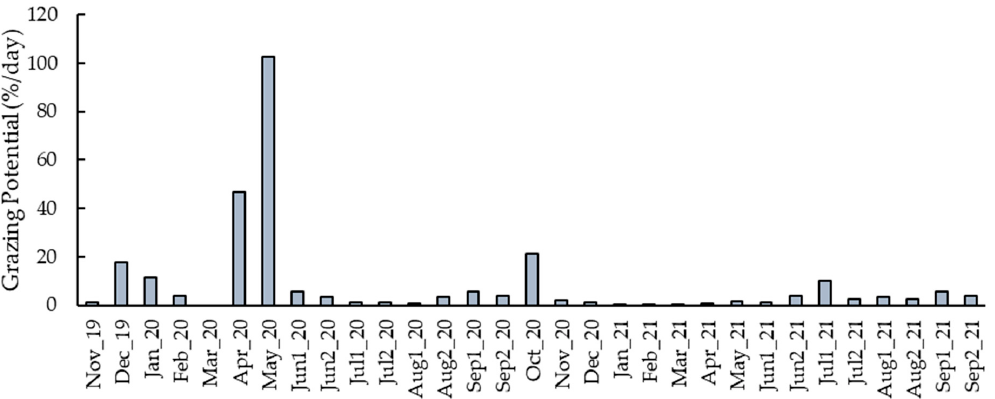
Figure 9. The grazing potential (GP) index in the Moglicë Reservoir during November 2019–Sep- tember 2021. September